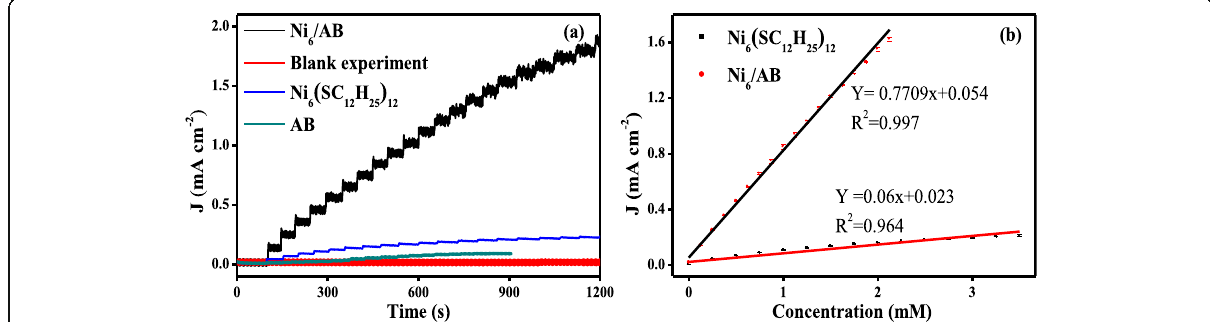
Fig. 5 a The responsing current density-time curve ( J - t ) of the Ni 6 /AB composites, Ni 6 (SC 12 H 25 ) 12 and AB with the successive addition of glucose in 0.1 KOH at + 1.46 V. The J - t curve in 0.1 M KOH was used as blank control. b The linear relationship between the current density and concentration of glucose from J - t curves of Ni 6 /AB composites and Ni 6 (SC 12 H 25 )